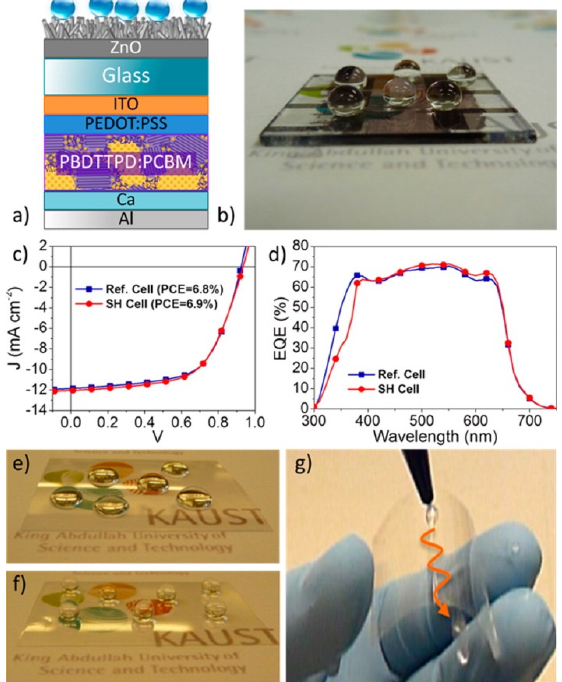
Figure 15. ( a ) Schematic of a BHJ polymer solar cell including the SiO 2 /ZnO nanocomposite; ( b ) Water droplets positioned on the front of the superhydrophobic device remain perfectly spherical; ( c ) J – V characteristic of a superhydrophobic (SH) cell (red circle) superimposed on that of a bare reference (Ref.) cell (blue square); AM1.5G solar illumination (100 mW ∙ cm − 2 ); ( d ) EQE spectra of the SH cell (red circle) and the Ref. cell (blue square); ( e ) Water droplets positioned on a bare transparent sheet of PET (2 × 2 in. 2 ); ( f ) Droplets positioned on superhydrophobic PET (static angle: 160°); ( g ) PET retains its superhydrophobicity upon repeated bending (×350) [43].